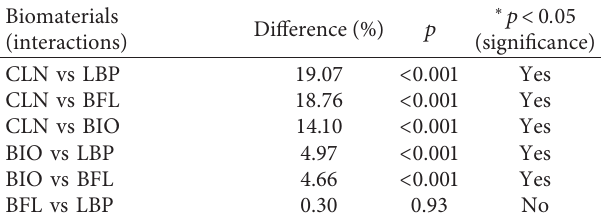
p < 0 . 05 denotes statistical significance. Table 4: Interactions among the percentual values of new bone formation of biomaterials used at 40-day period (Tukey test). Biomaterials